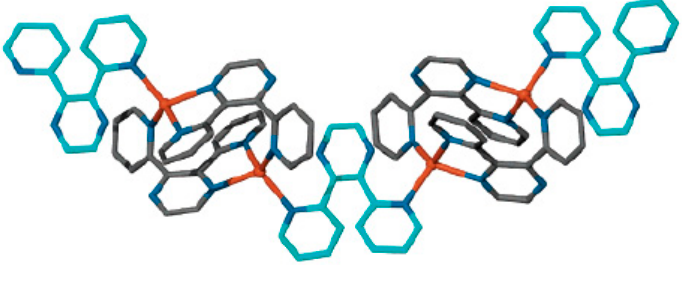
Figure 89. Fragment of the infinite {[Ag 2 (bppz) 3 ] 2+ } n chain of the complex {[Ag 2 (bppz) 3 ][1-(4-BrC 6 H 4 )-1-CB 11 H 11 ] 2· 1.5(MeCN)} n . Reprinted with permission from reference [75]. Copyright © (2007) American Chemical Society. Complex {Ag(DABCO)[1-Ph-1-CB 11 H 5 -7,8,9,10,11,12-I 6 ]} n was prepared by reaction of Ag[1-Ph-1-CB 11 H 5 -7,8,9,10,11,12-I 6 ] with 1,4-diazabicyclo[2.2.2]octane in acetonitrile [77]. The silver crystallographic equivalent DABCO ligands with an angle N-Ag-N of 111.40(14)° and Ag-N bonds anion with an angle I-Ag-I of 95.41(3)º and Ag…I distances of 2.8276(9) and 2.817(1) Å. The {Ag(DABCO)[1-Ph-1-CB 11 H 5 -7,8,9,10,11,12-I 6 ]} n coordination chains are comparable to those observed in {Ag(DABCO)[1-Ph-1-CB 9 H 9 ]} n (Figure 90) [77].